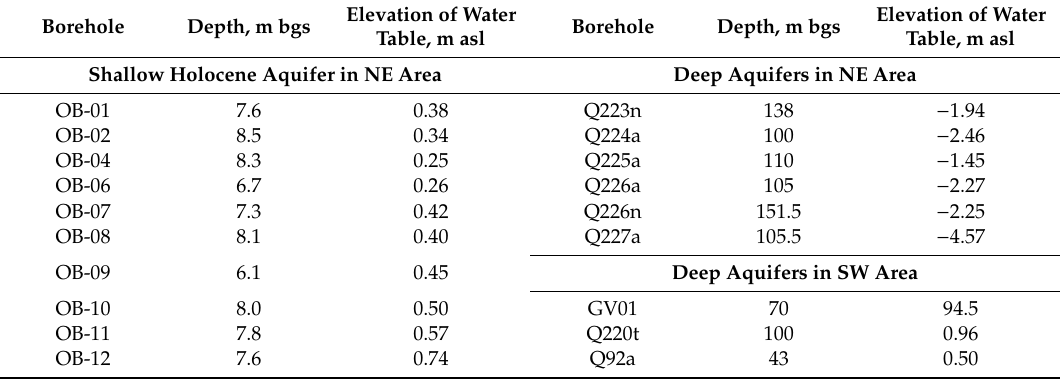
Table 1. Elevation of groundwater table in boreholes from those water samples were